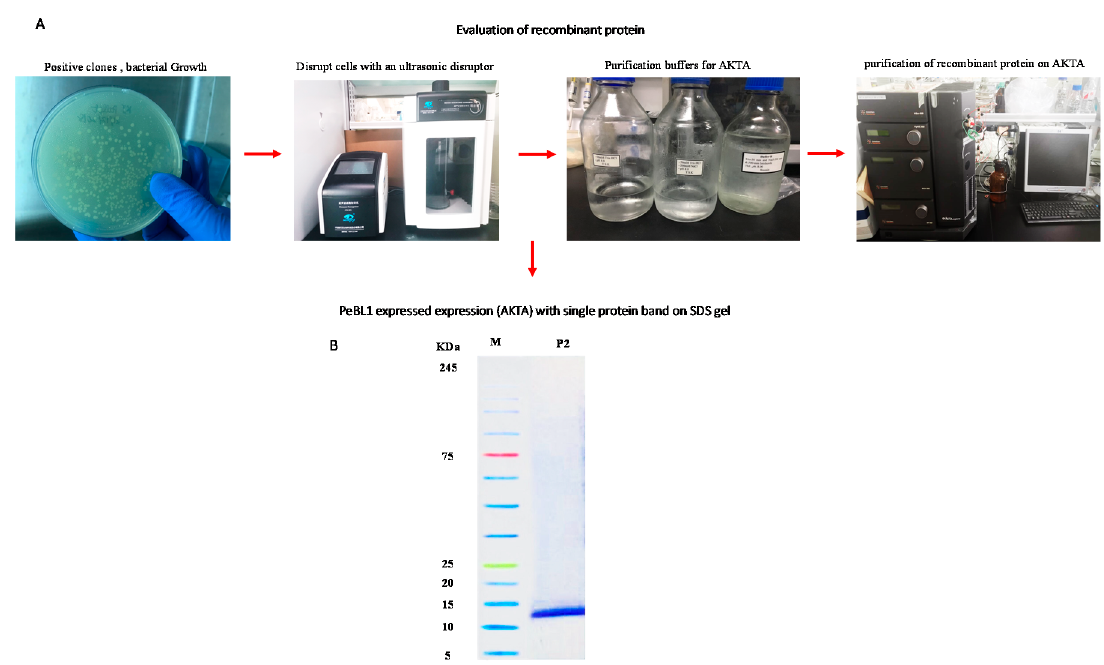
Figure 1. PeBL1 recombinant protein purification. ( A ) Evaluation of recombinant protein by using the Äkta explorer ( B ) His-Trap HP column used for the purification of total E. coli proteins. An elution buffer—25 mM Tris, 200 mM NaCl, 500 mM imidazole, and pH 8.0—was used to elute peak P2, which comprised recombinant PeBL1 with a flow rate of 5 mL/min. A HiTrap desalting column was used to load P2. The purified and desalted PeBL1 protein formed a single band of the molecular mass of 12 kDa on Tricine SDS-PAGE. Lane M: protein molecular mass marker; lane P2: peak P2. Table 1. M. persicae settled population data in PeBL1-treated, control, and bu ff er-treated cucumber seedlings showed di ff erences of M. persicae number after every 5, 10, and 15 days. Days after Aphid Inoculation Control Bu ff er PeBL1